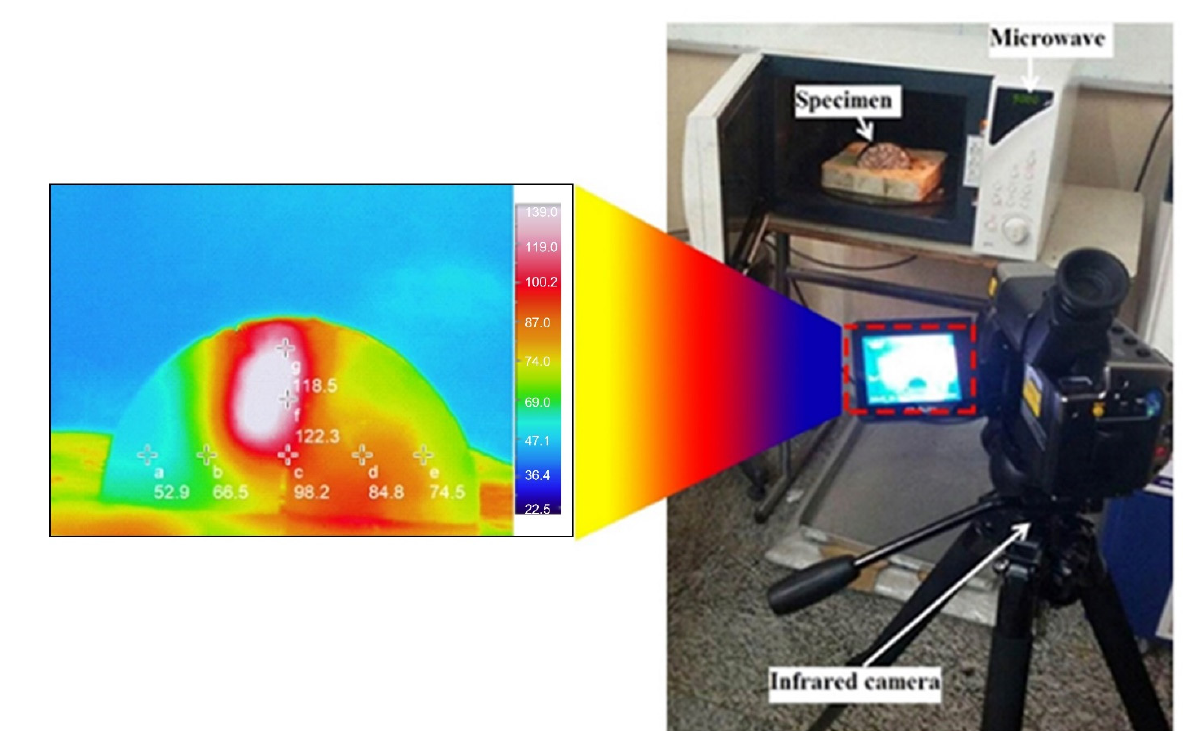
Figure 5. Thermal Imaging of the SCB Sample.